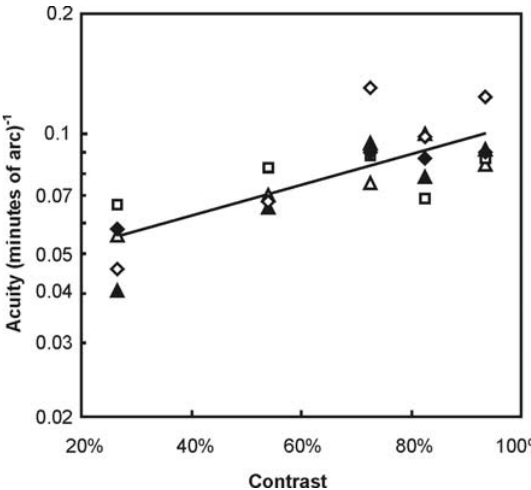
Figure 2. Effect of contrast on visual acuity of five great cormorants. The relationship is significant: log(acuity)= 2 1.36 + 0.38 (contrast). Symbols represent individual birds: m , n , X , e , % . Mean values 6 SEM: 0.054 6 0.005, 0.071 6 0.004, 0.096 6 0.009, 0.087 6 0.006, 0.095 6 0.007 (minutes of arc) 2 1 for contrast of 27, 54, 72, 82, and 93%, respectively.